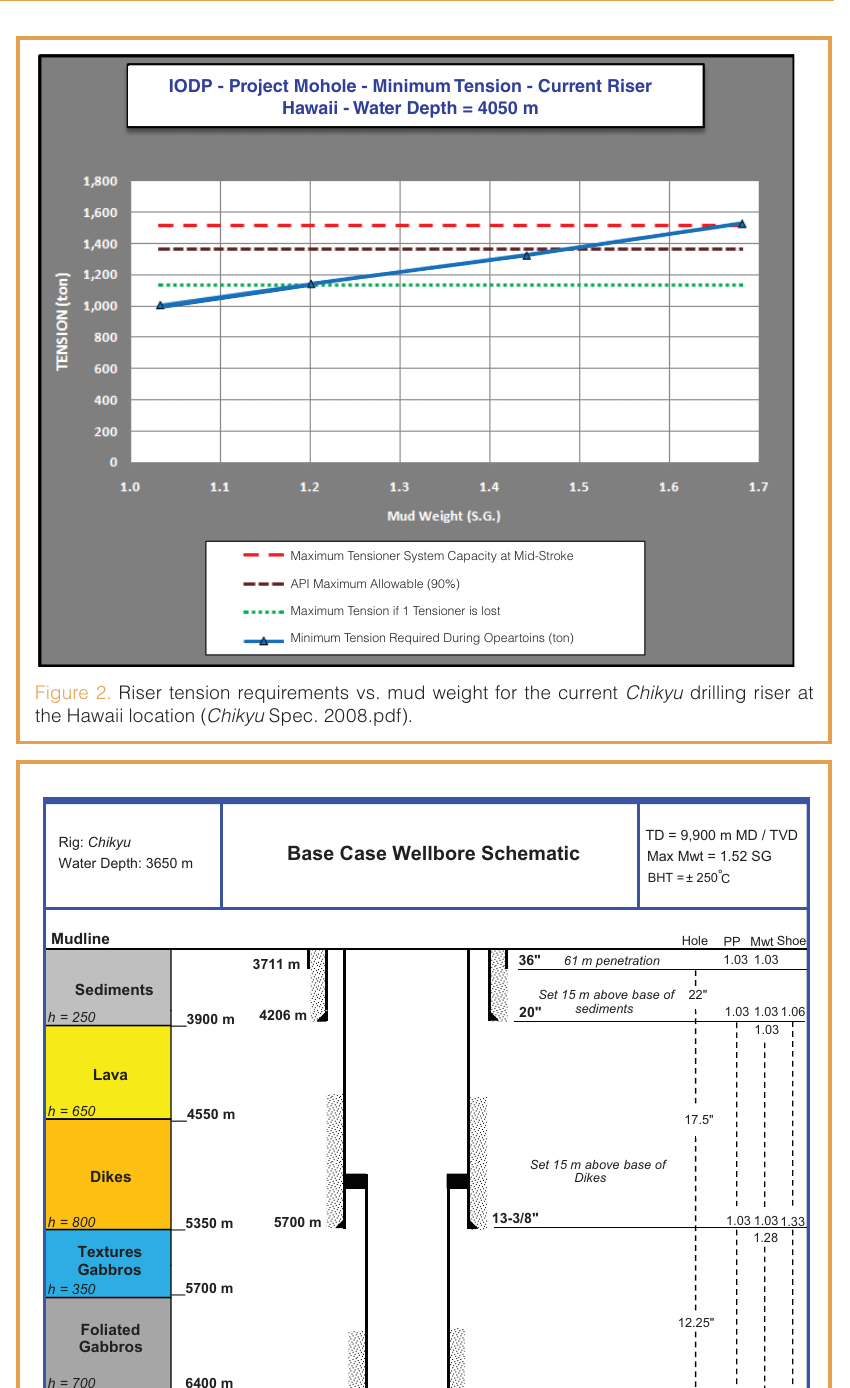
IODP - Project Mohole - Minimum Tension - Current Riser Hawaii - Water Depth = 4050 m